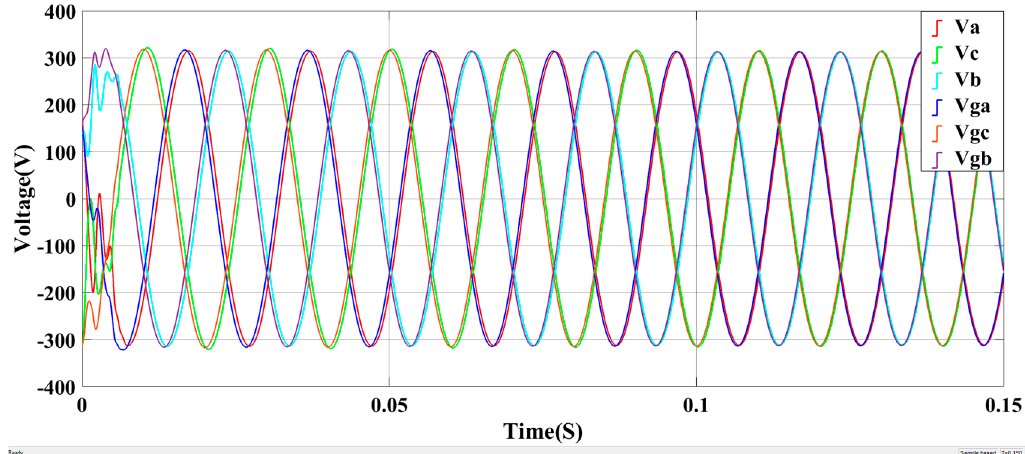
Figure 17. An output voltage comparison diagram between the inverter and the power grid under the proposed algorithm.